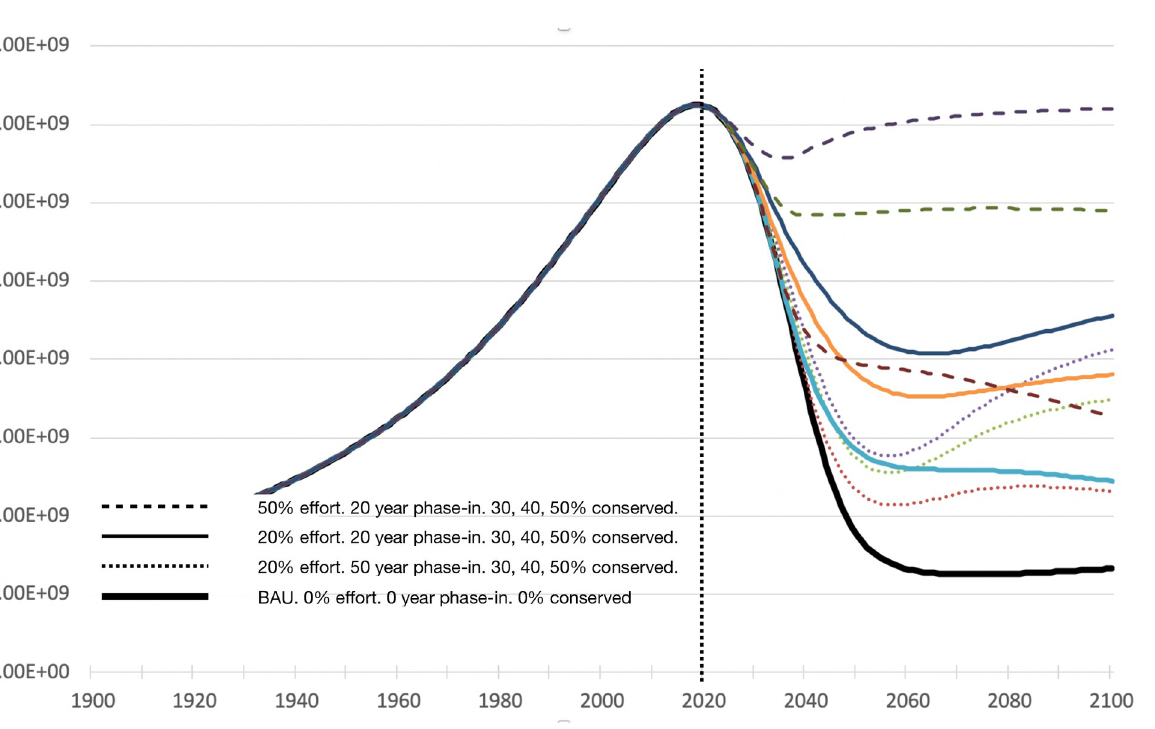
Fig 4. Half-Earth scenarios. Population projections for conservation efforts with various % enforcement, length of phase-in period and the % of ecosphere to be preserved, as compared to a BAU scenario. Dotted line is the present year, 2020.